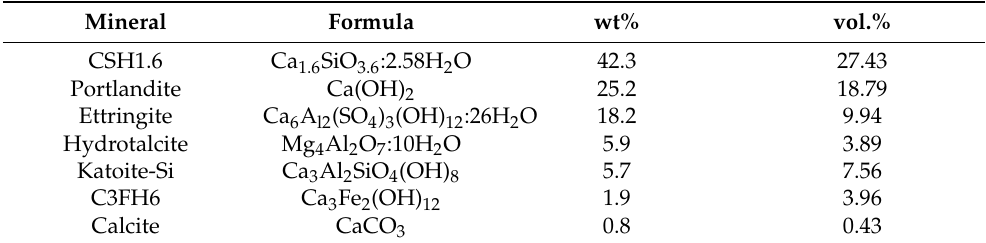
Table 4. Mineralogical composition of the cement sample (wt%) and conversion to percentages by volume